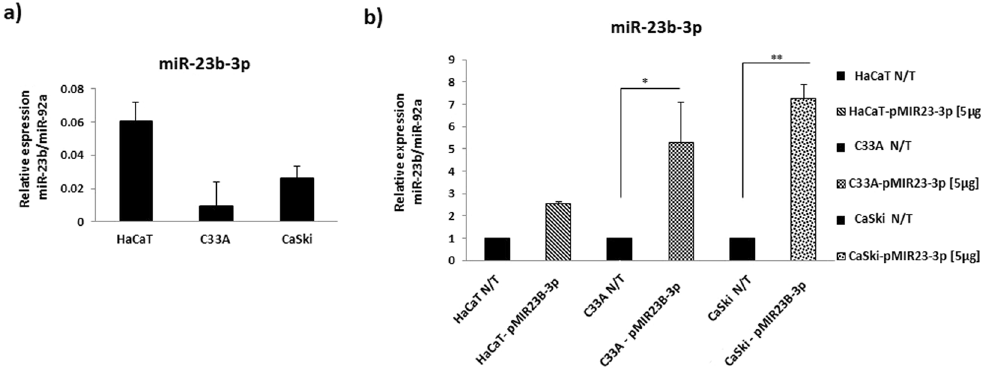
Figure 1. miR-23b-3p is reduced in CC cell lines. (a) The expression of miR-23b-3p in C33A and CaSki cells is lower than in HaCaT cells. (b) Transfection with the plasmid pMIR23B-3p significantly increases the expression of miR-23b-3p in CC cell lines. The levels of miR-23b-3p expression were analyzed via the 2 −Δ Ct method and normalized to miR-92a. Five micrograms of the plasmid pMIR23B-3p was used for the assays. N/T: Non- transfected. The data are expressed in averages + SE. * p < 0.05, ** p <